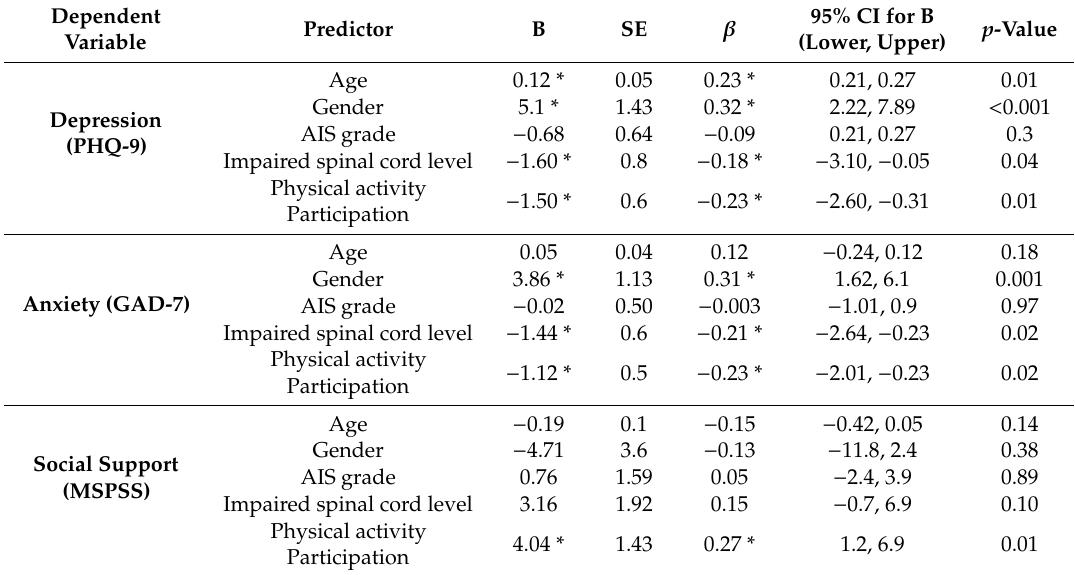
Table 3. Multivariate linear regression analysis predicting depression, anxiety, and social